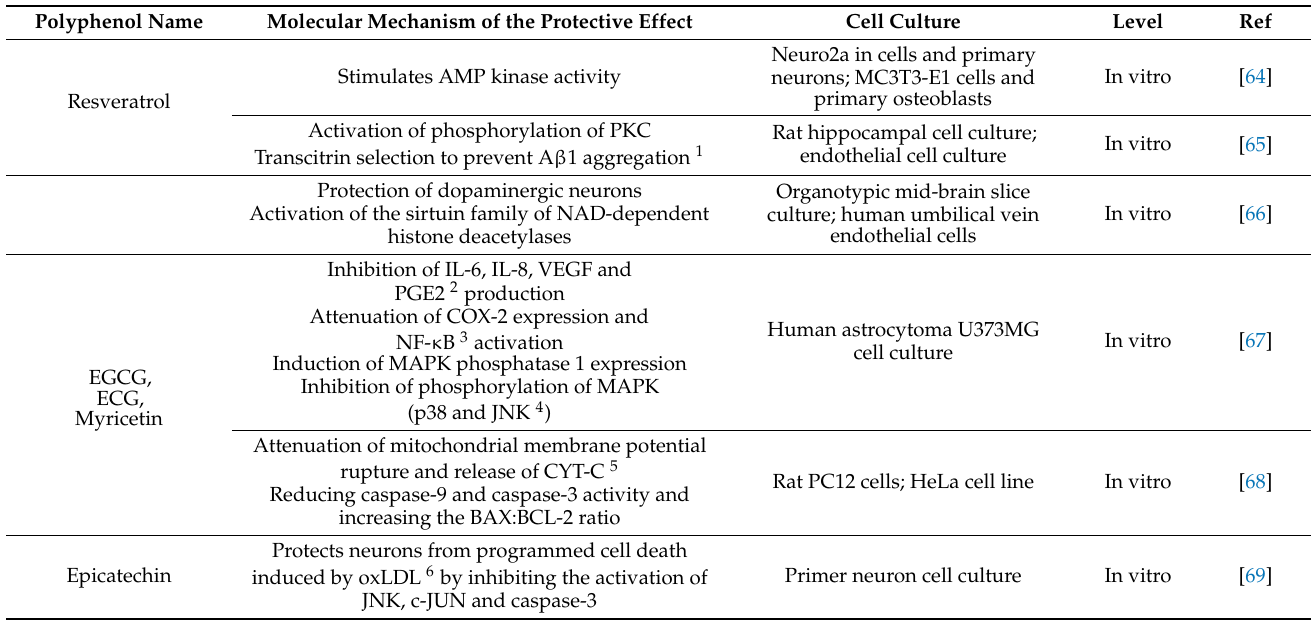
Table 7. The protective effects of polyphenols isolated from grape marc (grape seeds and skins) on the nervous